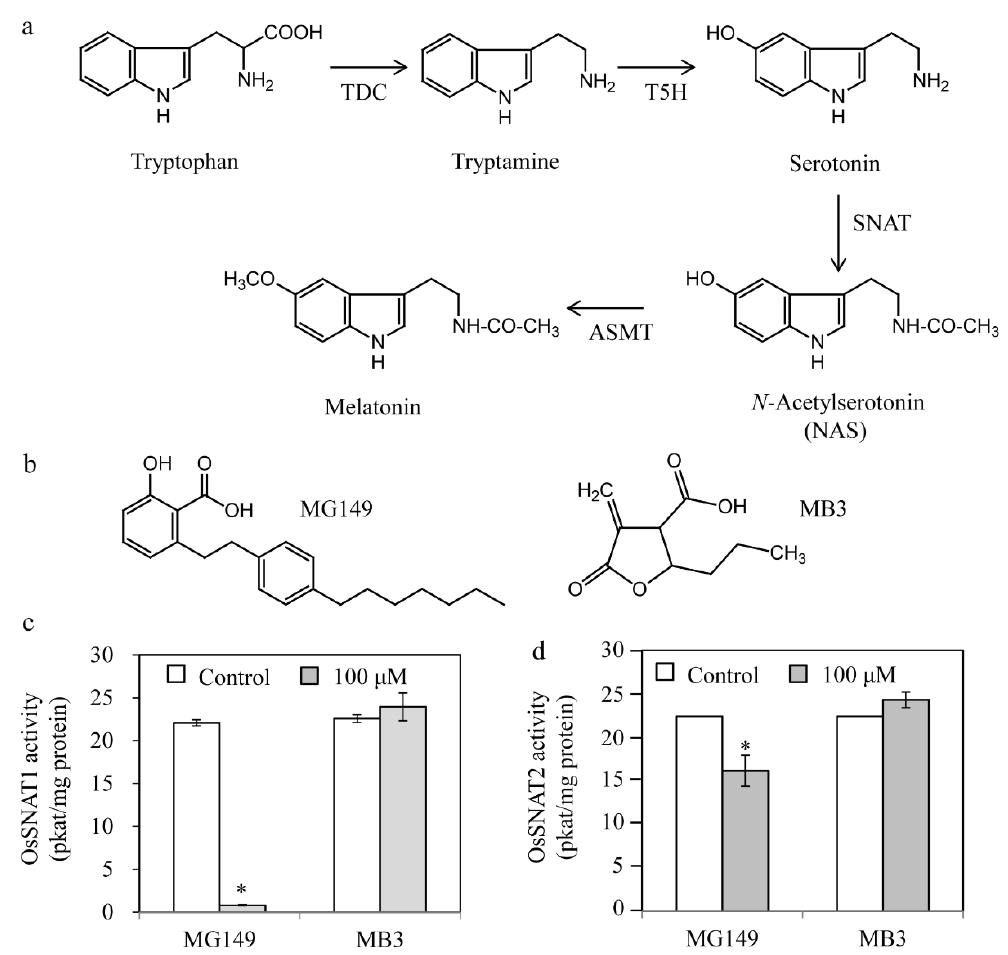
Figure 1. Inhibition of rice serotonin N -acetyltransferase by two histone acetyltransferase inhibitors. ( a ) Melatonin biosyn- thetic pathway with the corresponding enzymes. ( b ) Structures of the two histone acetyltransferase inhibitors. Inhibitory effects of MG149 and MB3 on rice recombinant ( c ) OsSNAT1 and ( d ) OsSNAT2. The control contained 0.1% ethanol. Bars show mean activity of three assays ± SE. Asterisks (*) indicate significant differences from the control (Tukey’s HSD; p < 0.05). TDC, tryptophan decarboxylase; T5H, tryptamine 5-hydroxylase; SNAT, serotonin N -acetyltransferase; ASMT, N - acetylserotonin O -methyltransferase.